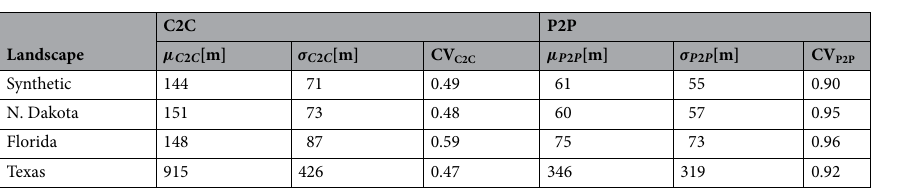
Table 1. Summary of the statistics for gap distribution calculated based on the C2C and P2P criteria in the four case studies. Data shown are for comparison between the C2C and P2P gap distances with z gw = z tp .